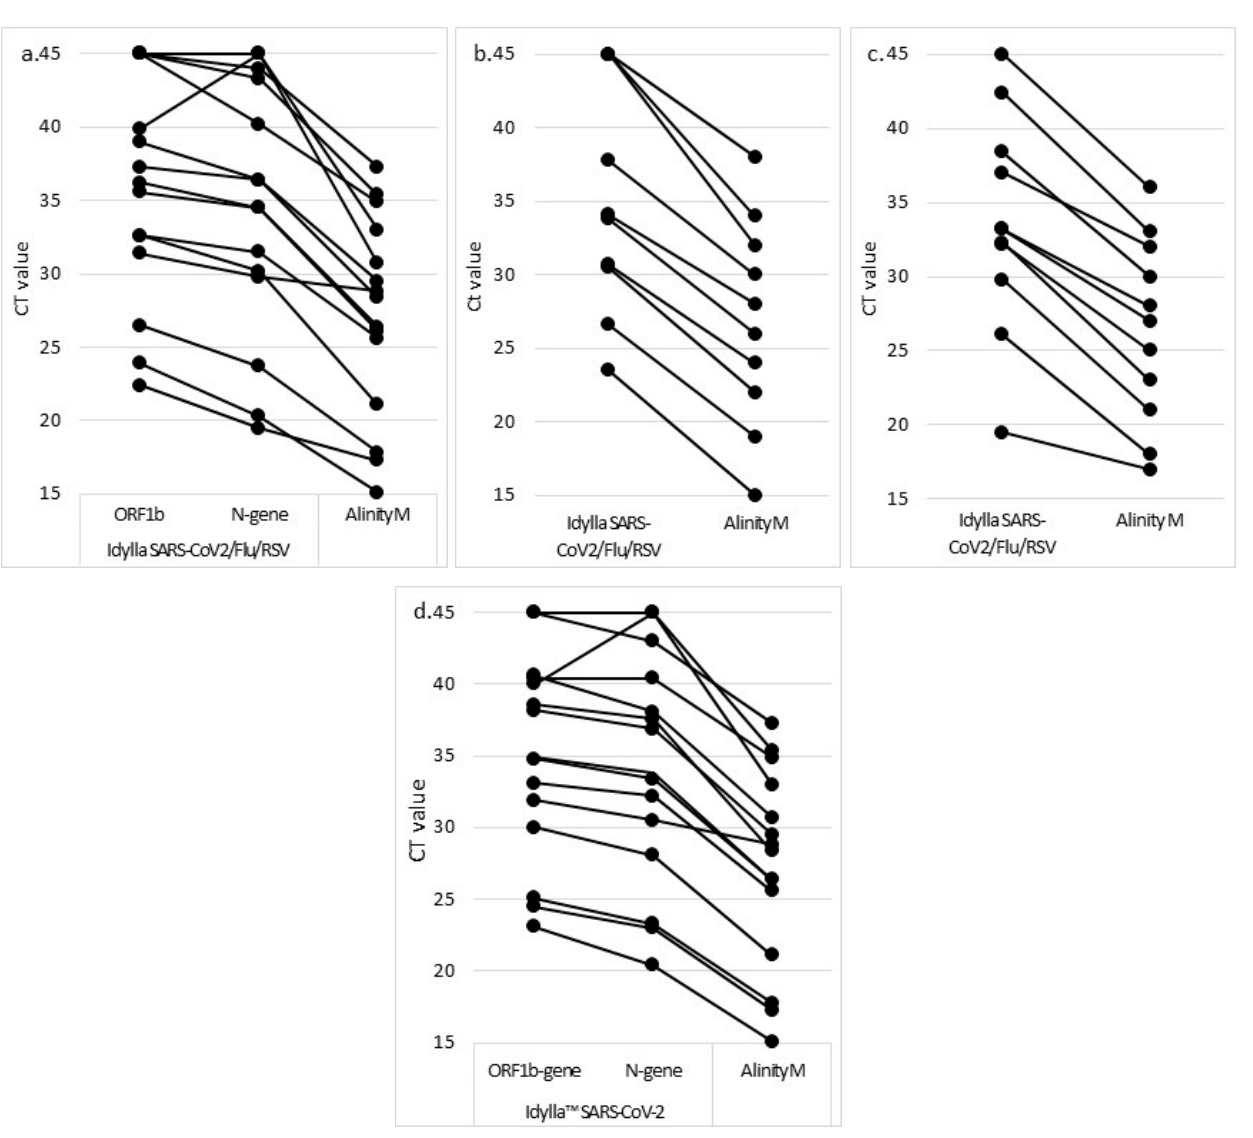
Figure 1. CT values of the viral targets obtained with the Idylla and the Alinity M assays during the study of the analytical performance. Idylla SARS-CoV2/Flu/RSV assay for SARS-CoV-2 ( a ), influenza A ( b ), and RSV ( c ) targets. Idylla SARS-CoV2 assay ( d ). One of 11 (9.1%) RSV-positive NPS and three of 10 (30.0%) influenza A-positive NPS